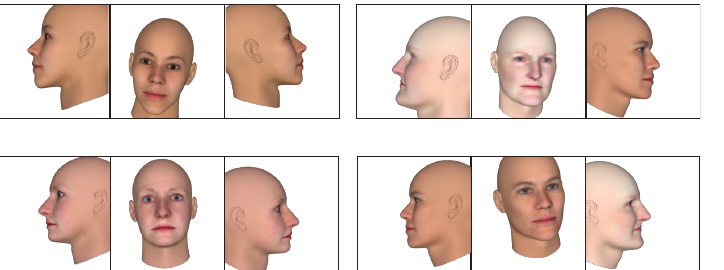
Figure 6. A FaceGen face with the different yaw, pitch, and roll angle ranges.